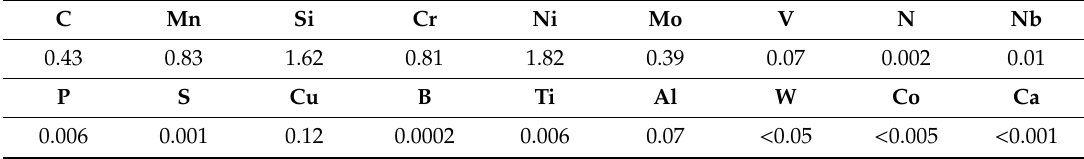
Table 1. Chemical composition of the 4340M steel (in wt.%).